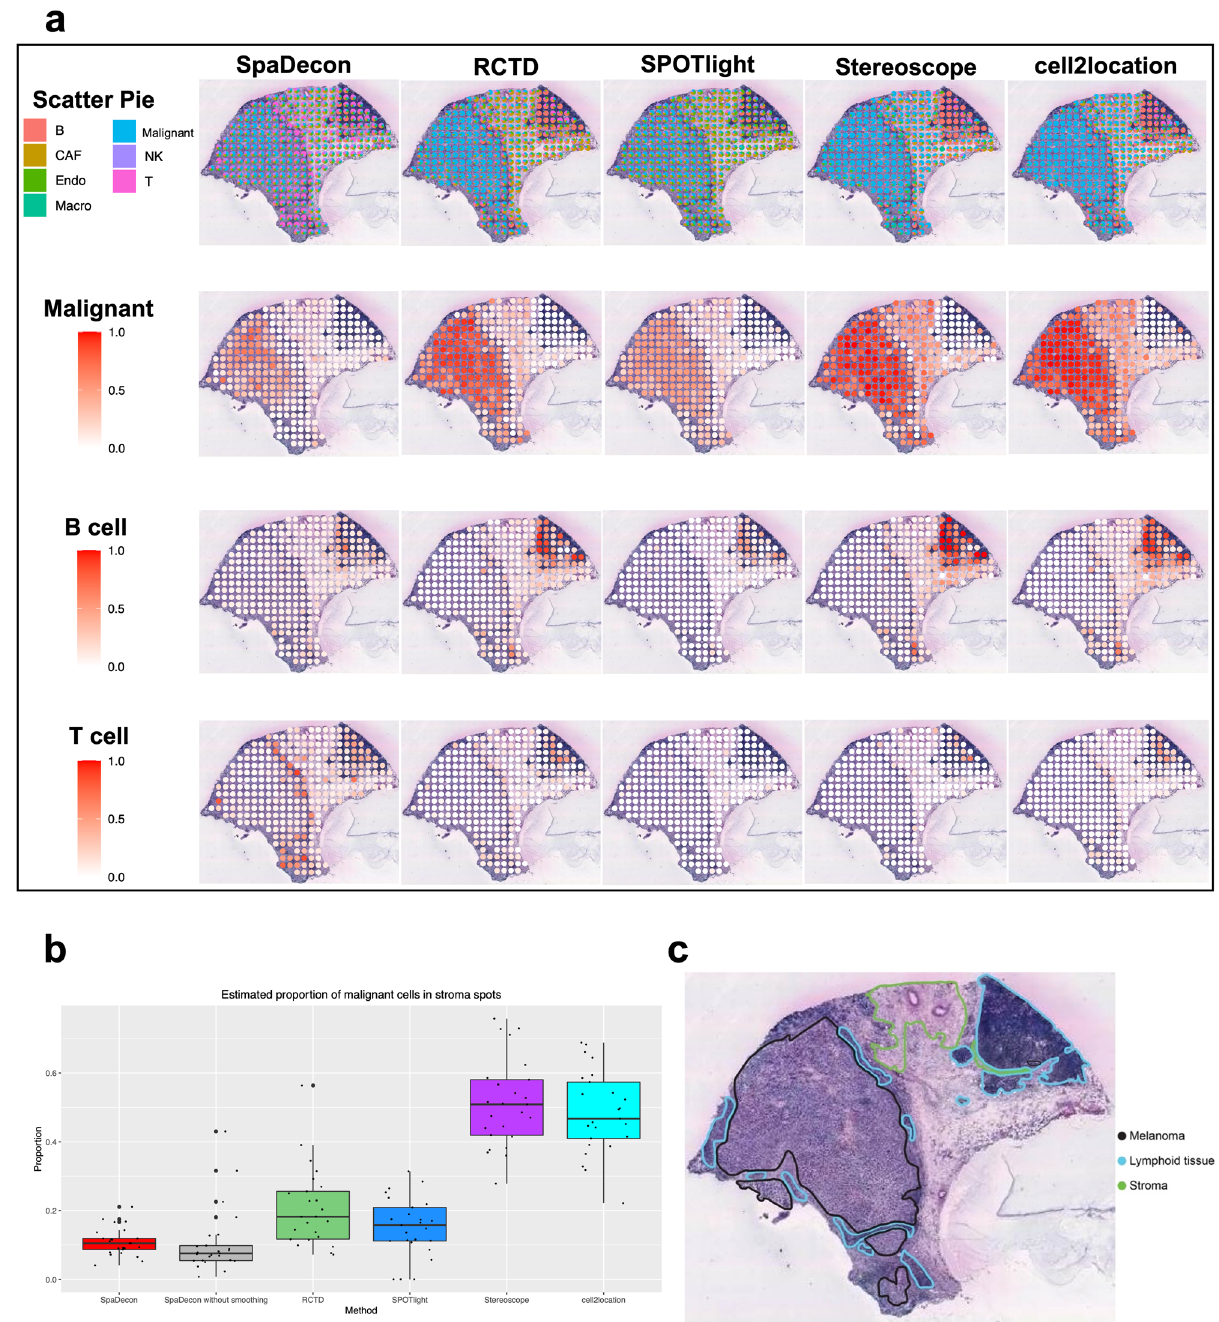
Fig. 4 Cell-type deconvolution results for stage III cutaneous malignant melanoma ST data. a Scatter pie plots displaying the cell-type proportion estimates of SpaDecon, RCTD, SPOTlight, Stereoscope, and cell2location at each spot, along with heatmaps showing the estimated distributions of malignant, B, and T cells. b Boxplot showing the proportions of malignant cells across stromal spots estimated by each method ( n = 25 spots). c Manual annotation of histology image of melanoma tissue section from which ST data were